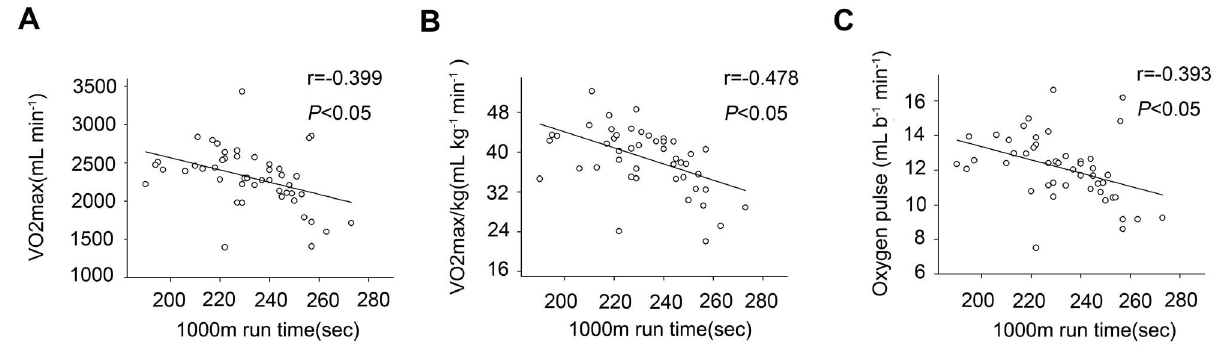
Figure 2. Significant correlations between 1000 m run time and indicators of exercise cardiopulmonary measurement. 1000 m run time was significantly and inversely correlated with VO 2 max (A), VO 2 max/kg (B) and Oxygen pulse (C).